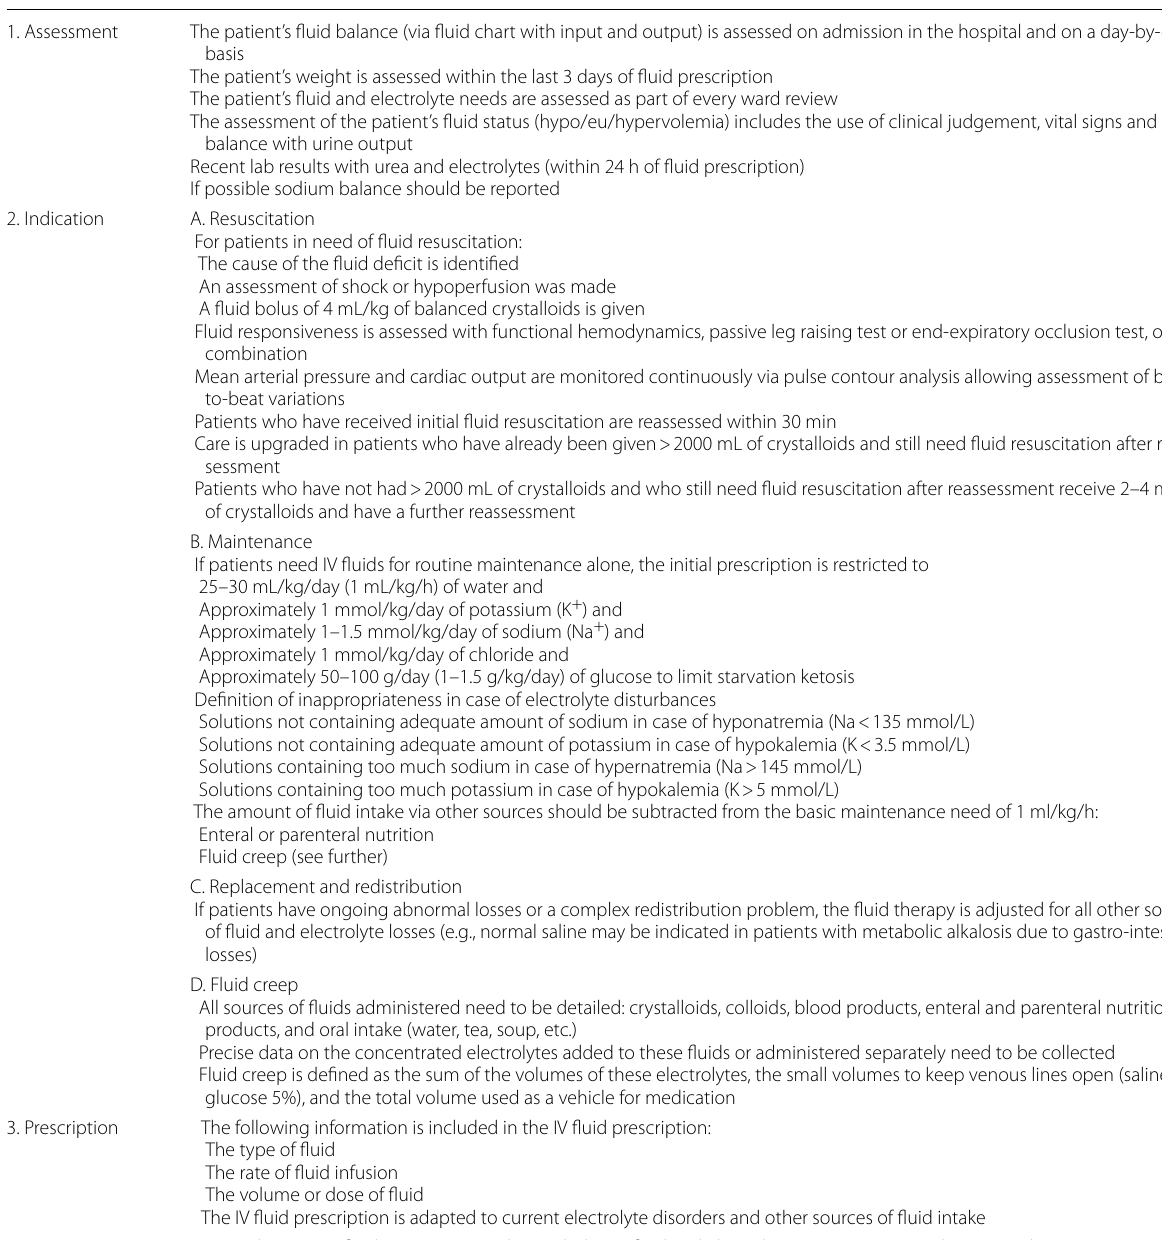
Table 5 The four stages to check for appropriateness of IV fluid therapy. Adapted with permission from Malbrain ML et al.